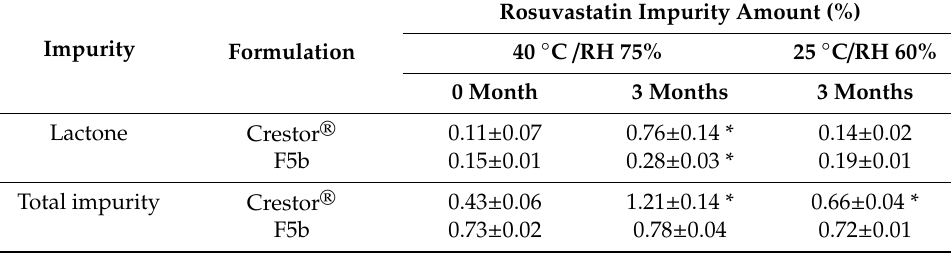
Table 4. Three month-storage stability of the multilayer-coated tablet (F5b) under di ff erent conditions (mean ± SD, n = 3).